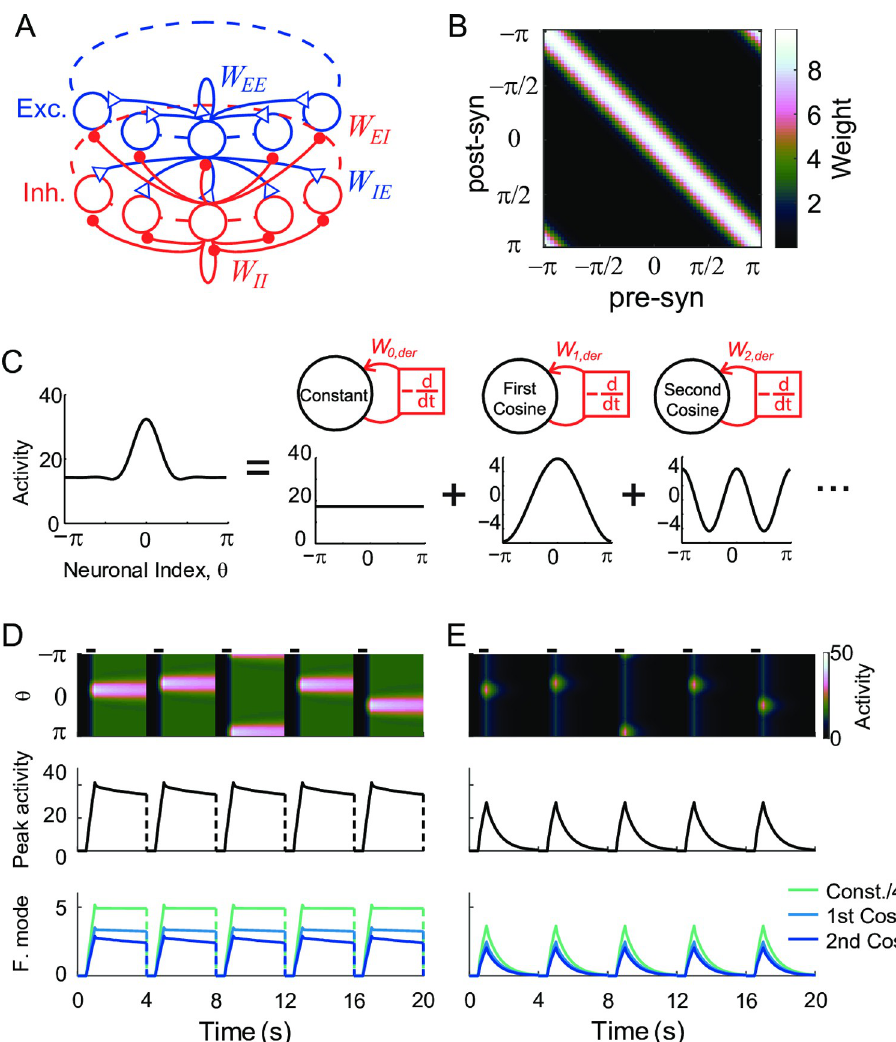
Fig 5. Location-coded persistent activity and its disruption under perturbation of tuning. A: Schematics of the spatial structure of network for location-coded memory. We considered that both excitatory and inhibitory neurons are organized in a columnar structure where each column consists of neurons with a similar preferred feature of the stimulus. Blue and red represent excitatory and inhibitory connections, respectively. B: Example connectivity matrix showing symmetry under translation. We considered the memory neurons encode the spatial information during the delay period, which lies on a circle, represented by θ ranging between - π and π . We assumed that before perturbation, the synaptic strengths depend only on the difference between feature preference of post and presynaptic neurons. C: Decomposition of spatially patterned activity into Fourier modes under translation-invariance. Figure adapted from [13]. D-E: Location-coded persistent activity under E-I balance (D) and its disruption under 10% global perturbation in the E-to-E connection (E). The upper panels show the activity of all neurons during five consecutive trials with each neuron labeled by its preferred feature. The middle panels show the activity of the neuron at the stimulus center and the lower panels show the activity of 3 Fourier modes with the constant mode shrunk by a factor of 1/4 for better